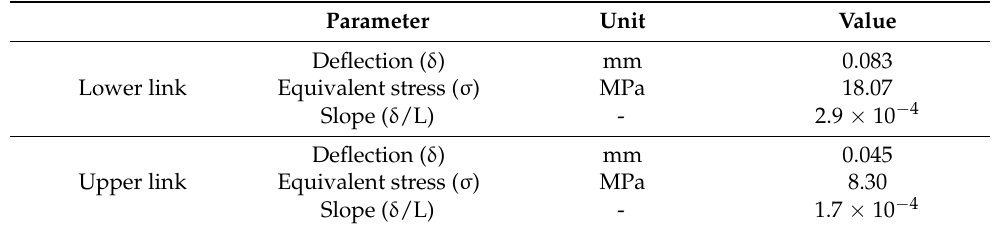
Figure 2. Meshes and load conditions for the FEA model of each link: ( a ) Upper link mesh; ( b ) upper link load conditions; ( c ) lower link mesh; and ( d ) lower link load conditions.